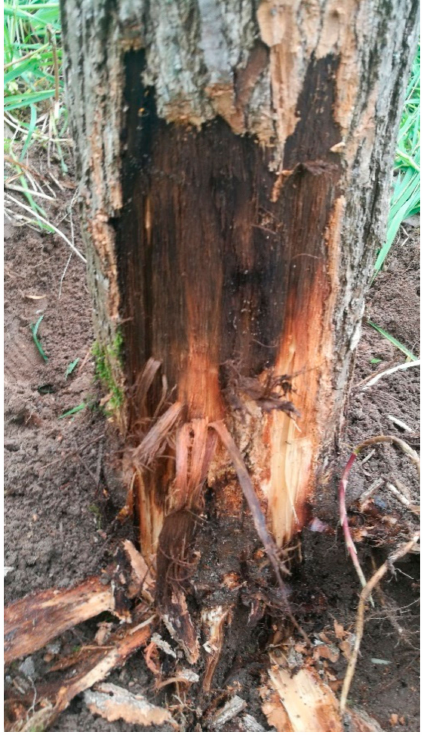
Figure 2. Necrosis and decay at the base of the trunk of a diseased